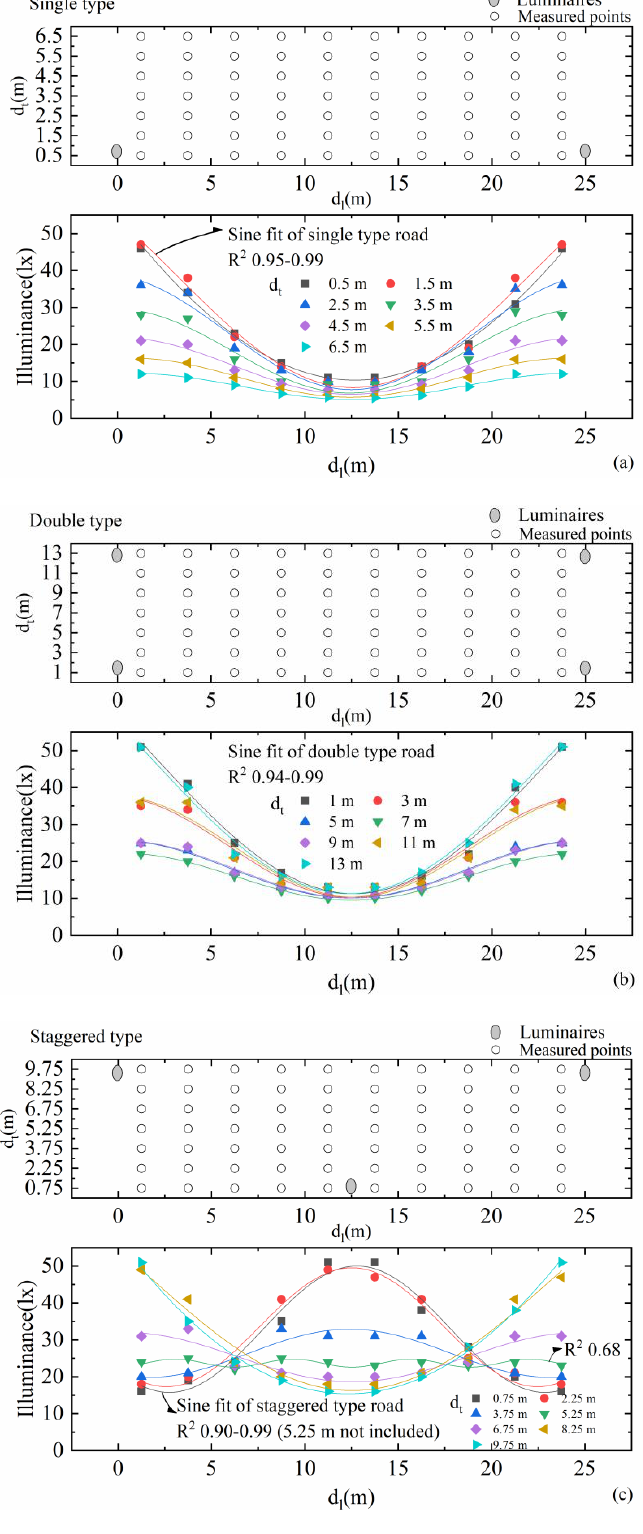
Figure 2. The illuminance distributions in longitudinal directions at different transverse distance d t s of three kinds road types: ( a ) single type, ( b ) double type, and ( c ) staggered type. They are fitted with sine functions at different d t s reaching R 2 0.95–0.99 for the single type, 0.94–0.99 for the double type, and 0.90–0.99 for the staggered type, excluding the one at d t = 5.25 m of